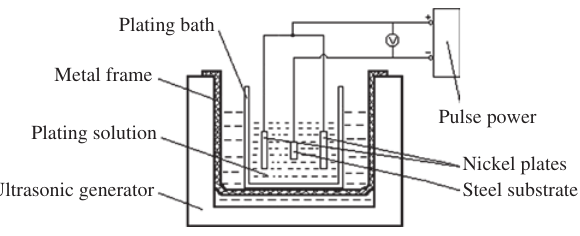
Figure 1 Schematic of the experimental setup.